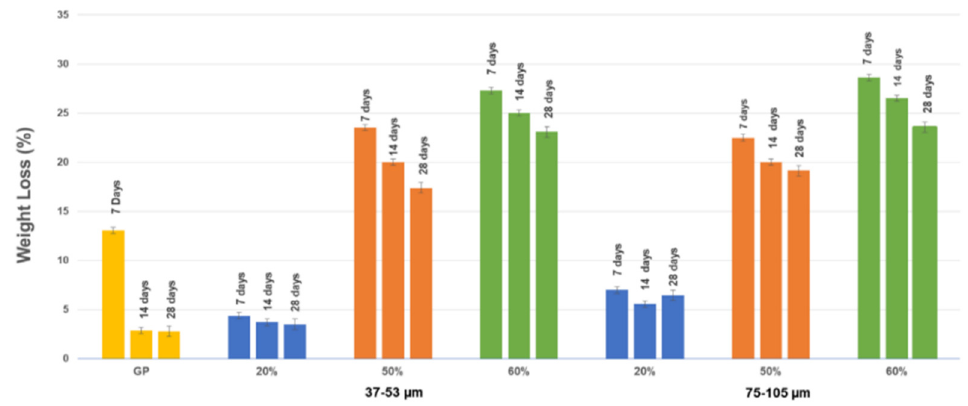
Figure 3. Values of weight loss after the integrity tests for samples GP and GP/WG from 37–53 μ m and 75–105 μ m series.